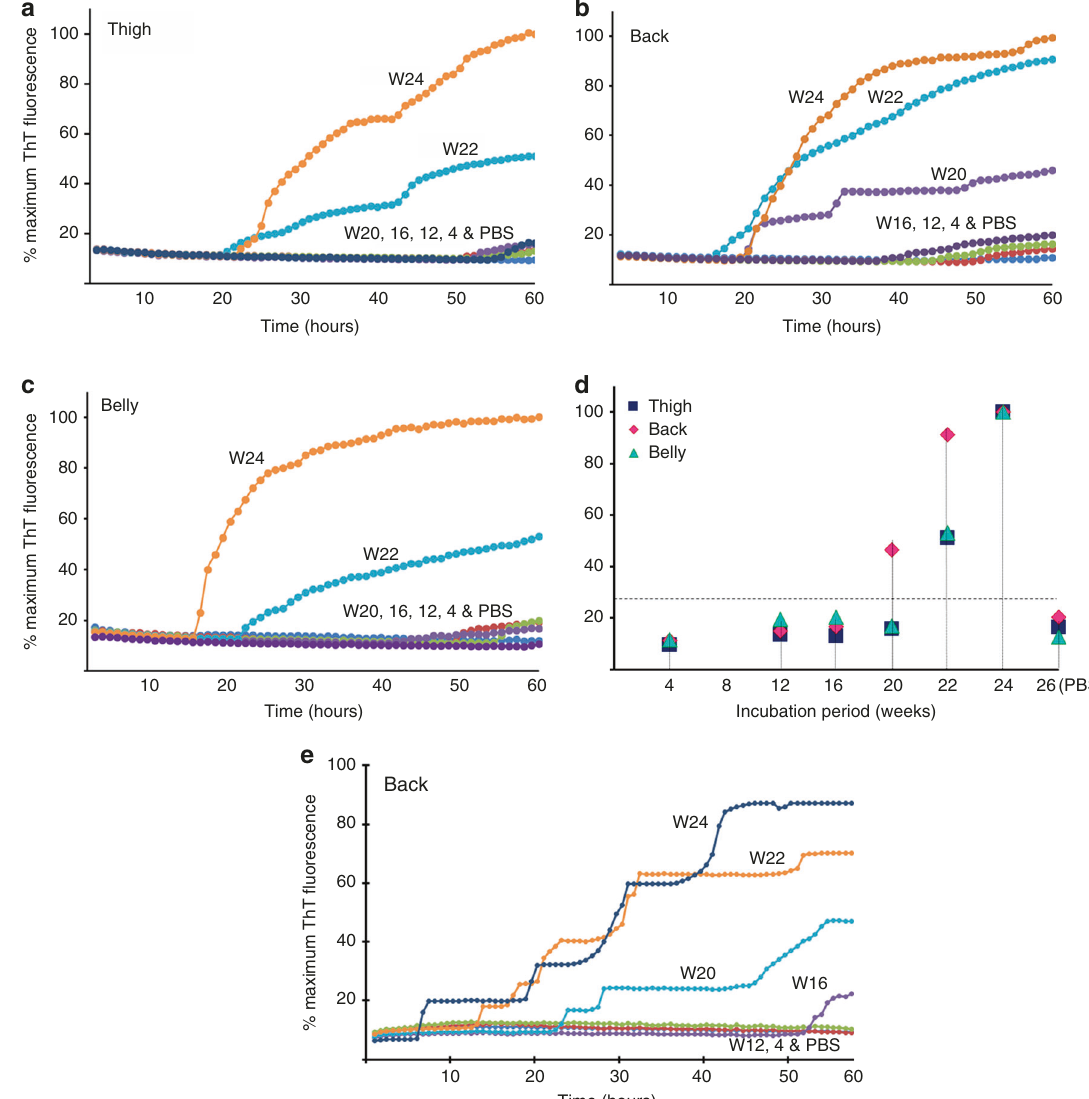
Fig. 5 Detection of skin prion-seeding activity by RT-QuIC in Tg40h mice. Prion-seeding activity of thigh ( a ) back ( b ) and belly ( c ) skin homogenates from the Tg40h mice inoculated with sCJDMM1 brain homogenate and killed at 4, 8, 12, 16, 20, 22, or 24 wpi was detected by RT-QuIC assay with recombinant hamster PrP90-231 as the substrate. PBS represents-negative control Tg40h mice that were inoculated intracerebrally with PBS for 26 weeks. d Scatter plot of average of skin prion-seeding activity of thigh, back, or belly from sCJDMM1-inoculated Tg40h mice at 4, 12, 16, 20, 22, and 24 wpi and PBS- inoculated hamsters killed at 26 wpi. Three animals were examined for each time point. The horizontal dotted line indicates the 27% calculated ThT fl uorescence threshold based on the means of negative controls plus 4 standard deviations. e Skin samples from back area of sCJDMM1-inoculated Tg40h mice at 4, 12, 16, 20, 22, and 24 wpi and PBS-inoculated control mice were subjected to RT-QuIC assay with recombinant human PrP90-231 as the substrate. The RT-QuIC trace showed is representative of three-independent experiments with three different animals at each time